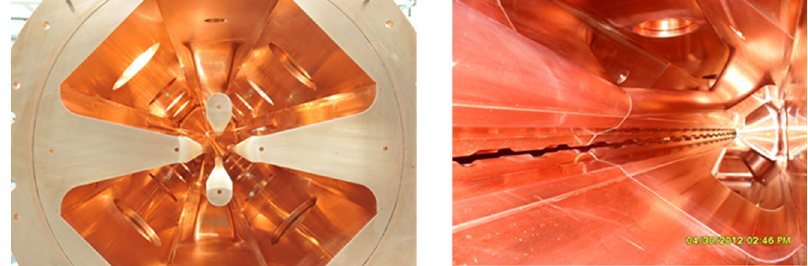
FIG. 10. Internal view of the RFQ from the low-energy end (left) and from the third segment to the high-energy end